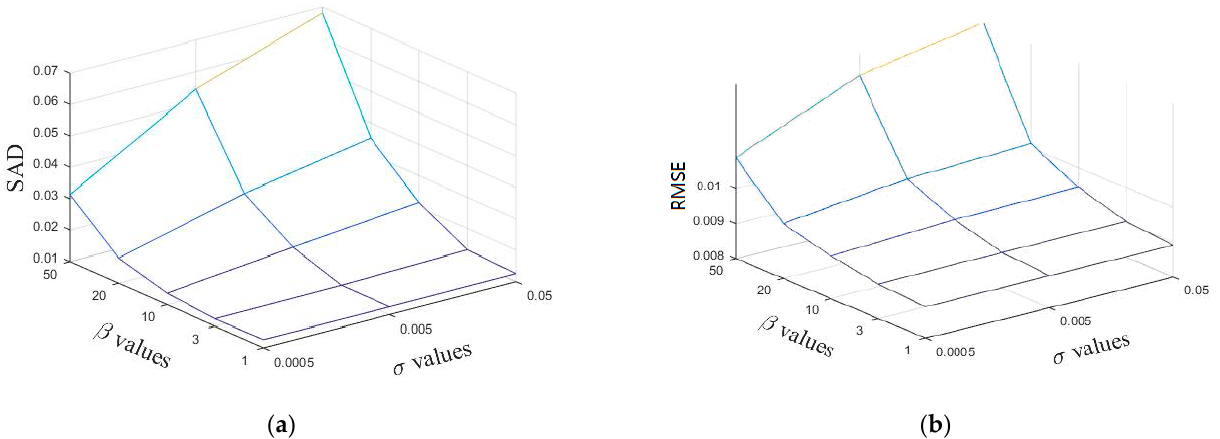
Figure 5. Performance of SSC-NMF with respect to parameters β , σ in terms of ( a ) SAD and ( b ) RMSE.